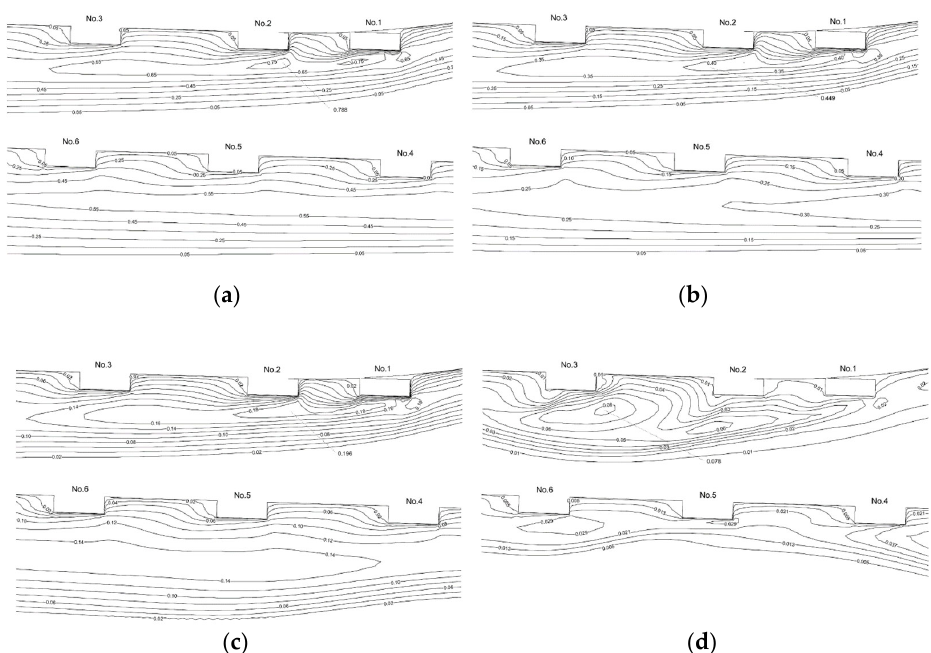
Figure 8. Distribution of turbulent kinetic energy: ( a ) 4.0 m/s, ( b ) 3.0 m/s, ( c ) 2.0 m/s, and ( d ) 1.0 m/s.